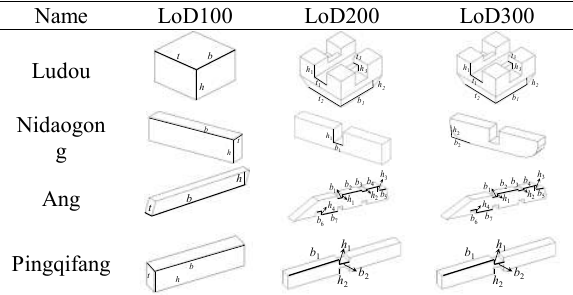
Table 1. Multi-LoD models for typical